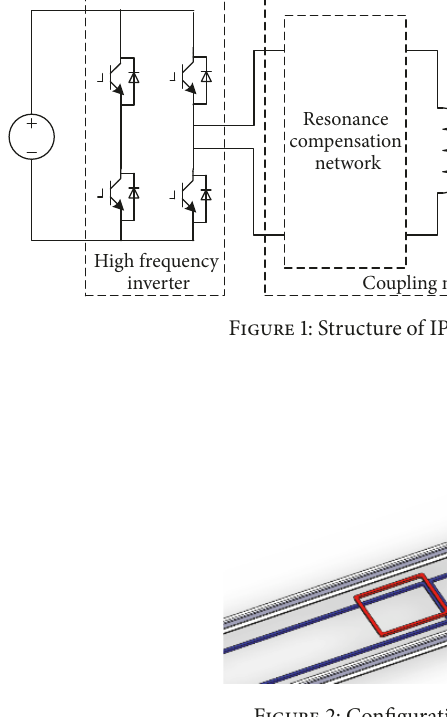
Figure 2: Configuration of primary and secondary